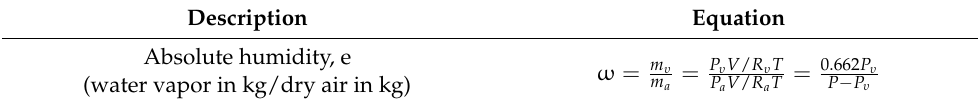
Table 5. Absolute humidity equation.